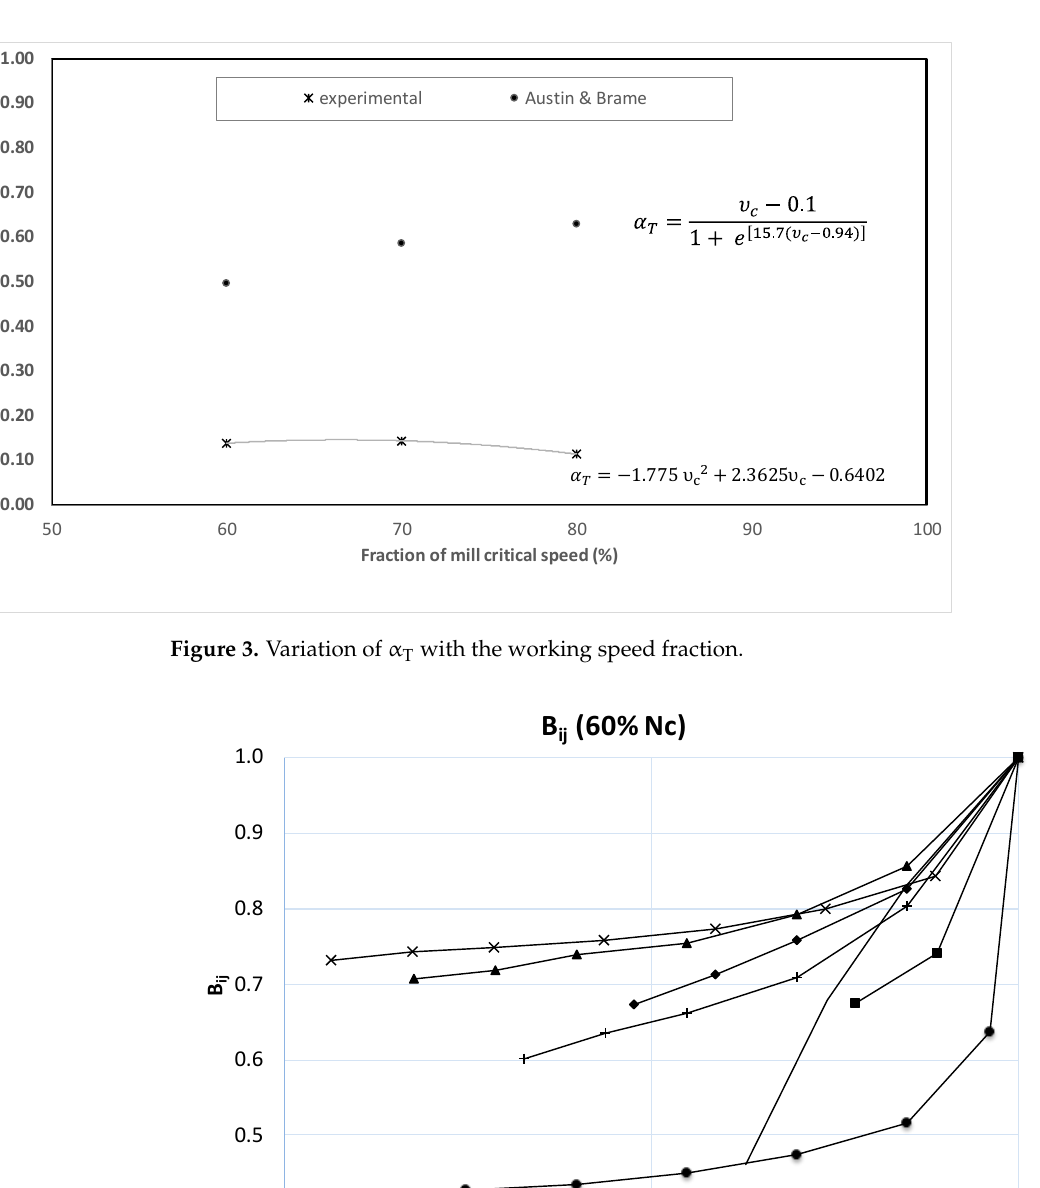
Figure 5. Behavior of the fracture function ( B ij ), with respect to particle size. 70% working speed Nc (Barruecopardo ore).